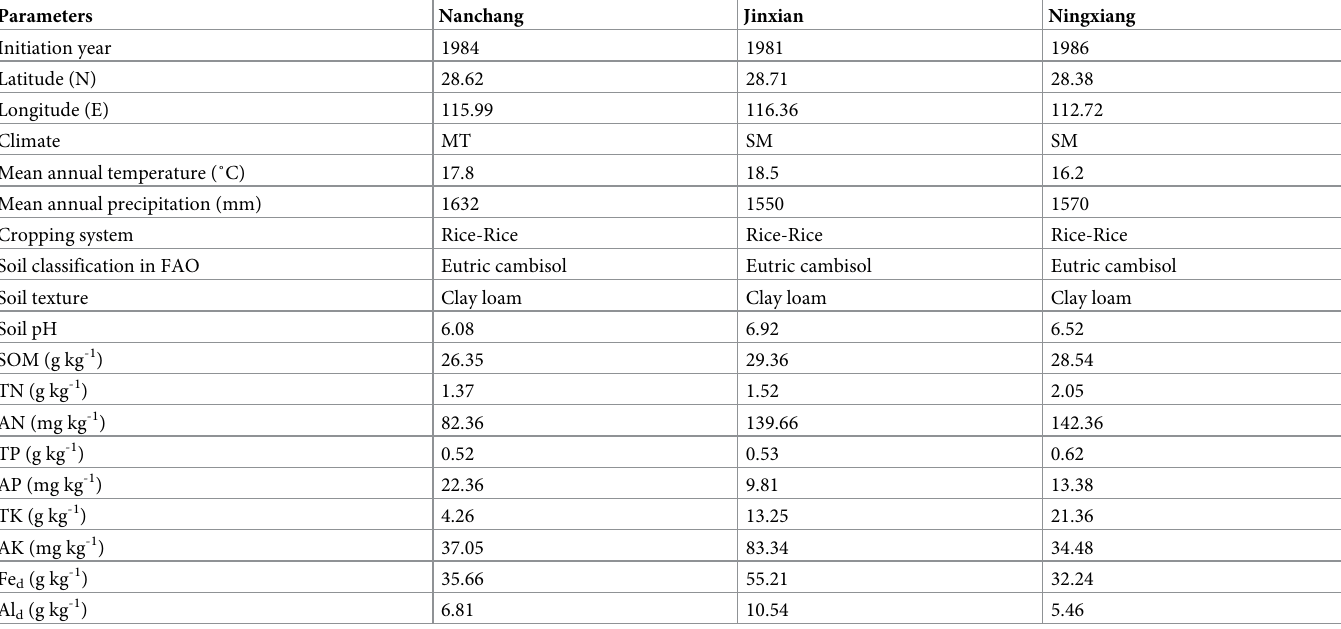
Table 1. Locations, climate conditions and initial surface soil properties of the three long-term experimental sites.